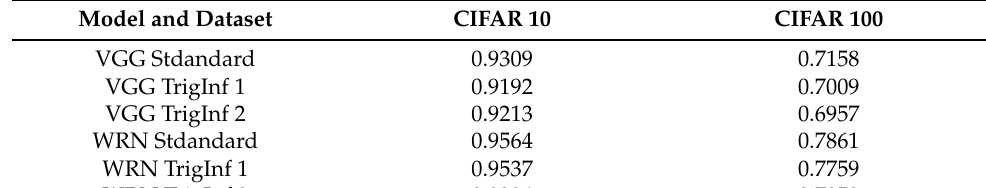
Table 5. Final validation accuracy of CIFAR-10 and CIFAR-100.